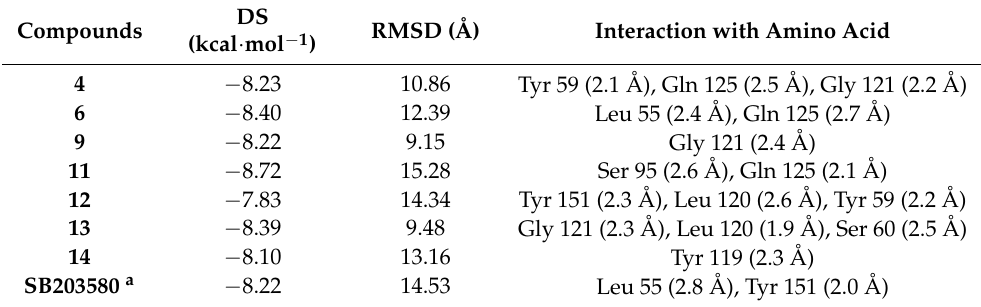
Table 4. Docking simulation results with docking score energy (DS) and root-mean-square deviation (RMSD) between isolated compounds ( 4 , 6 , 9 , and 11 – 14 ) and the 2AZ5 protein.